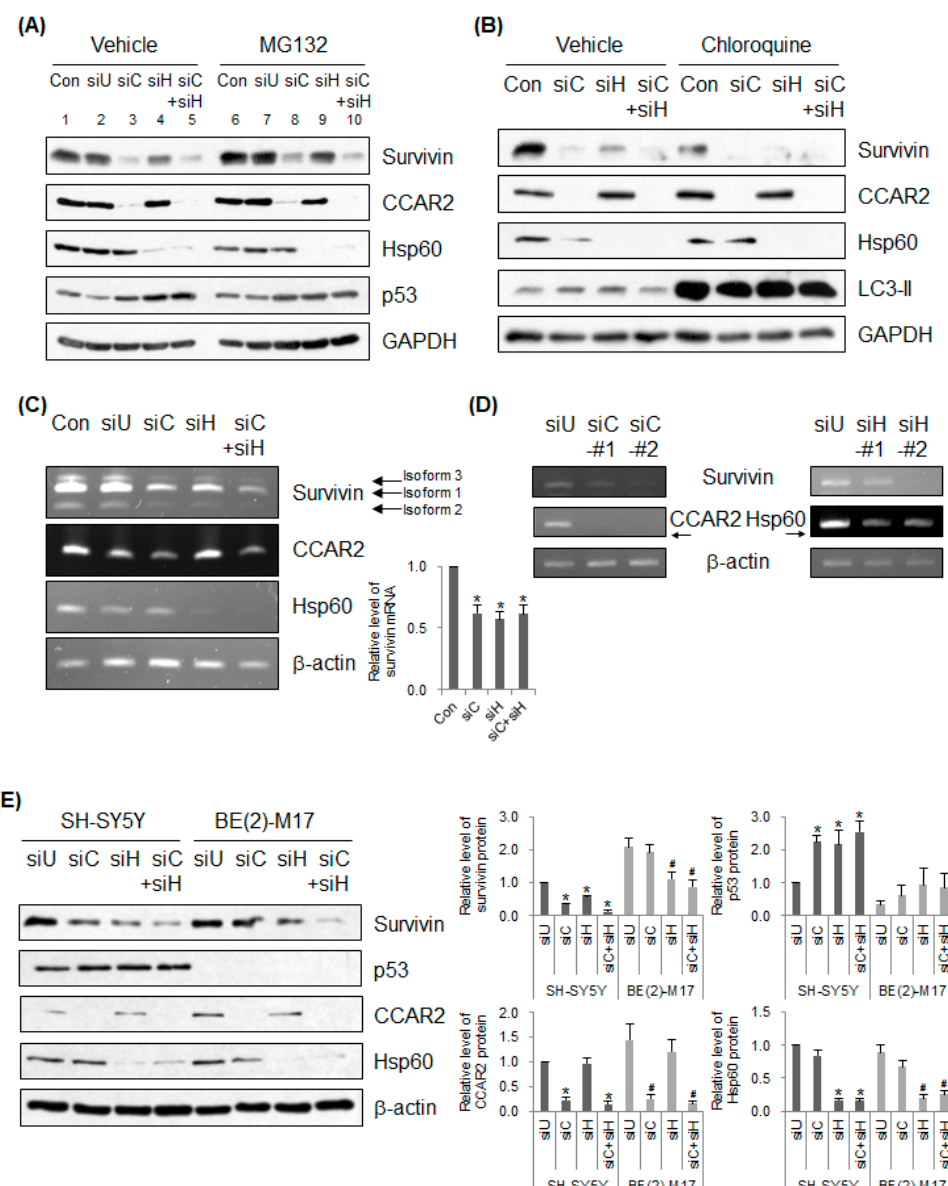
Figure 3. Deficiency of CCAR2 or Hsp60 reduces expression of survivin mRNA. SH-SY5Y ( A – E ) or BE(2)-M17 cells ( E ) were transfected with Universal (siU), CCAR2 (siC), or Hsp60 (siH) siRNA. ( A , B ) Forty-eight hours later, the level of survivin protein was examined by western blotting. Cells deficient in CCAR2 and Hsp60 were treated with 25 µ M MG132 ( A ) or 100 µ M chloroquine ( B ) 4 h or 24 h prior to cell lysis, respectively. ( C , D ) The level of survivin mRNA in each group of siRNA-transfected cells was measured by RT-PCR. ( C ) Levels were normalized against β -actin and quantified using ImageJ software. The relative level of survivin mRNA is expressed as the mean ± standard error of the mean (SEM) ( n = 3). Asterisks (*) denote statistically significant differences ( p < 0.05, one-way ANOVA). ( D ) Two different siRNAs targeting CCAR2 and Hsp60 were used to knock down their expressions. ( E ) The level of each protein was examined by western blotting. The relative level is expressed as the mean ± standard error of the mean (SEM) ( n = 3). Indicators (*, #) denote statistically significant differences from the corresponding control cells ( p < 0.05, one-way